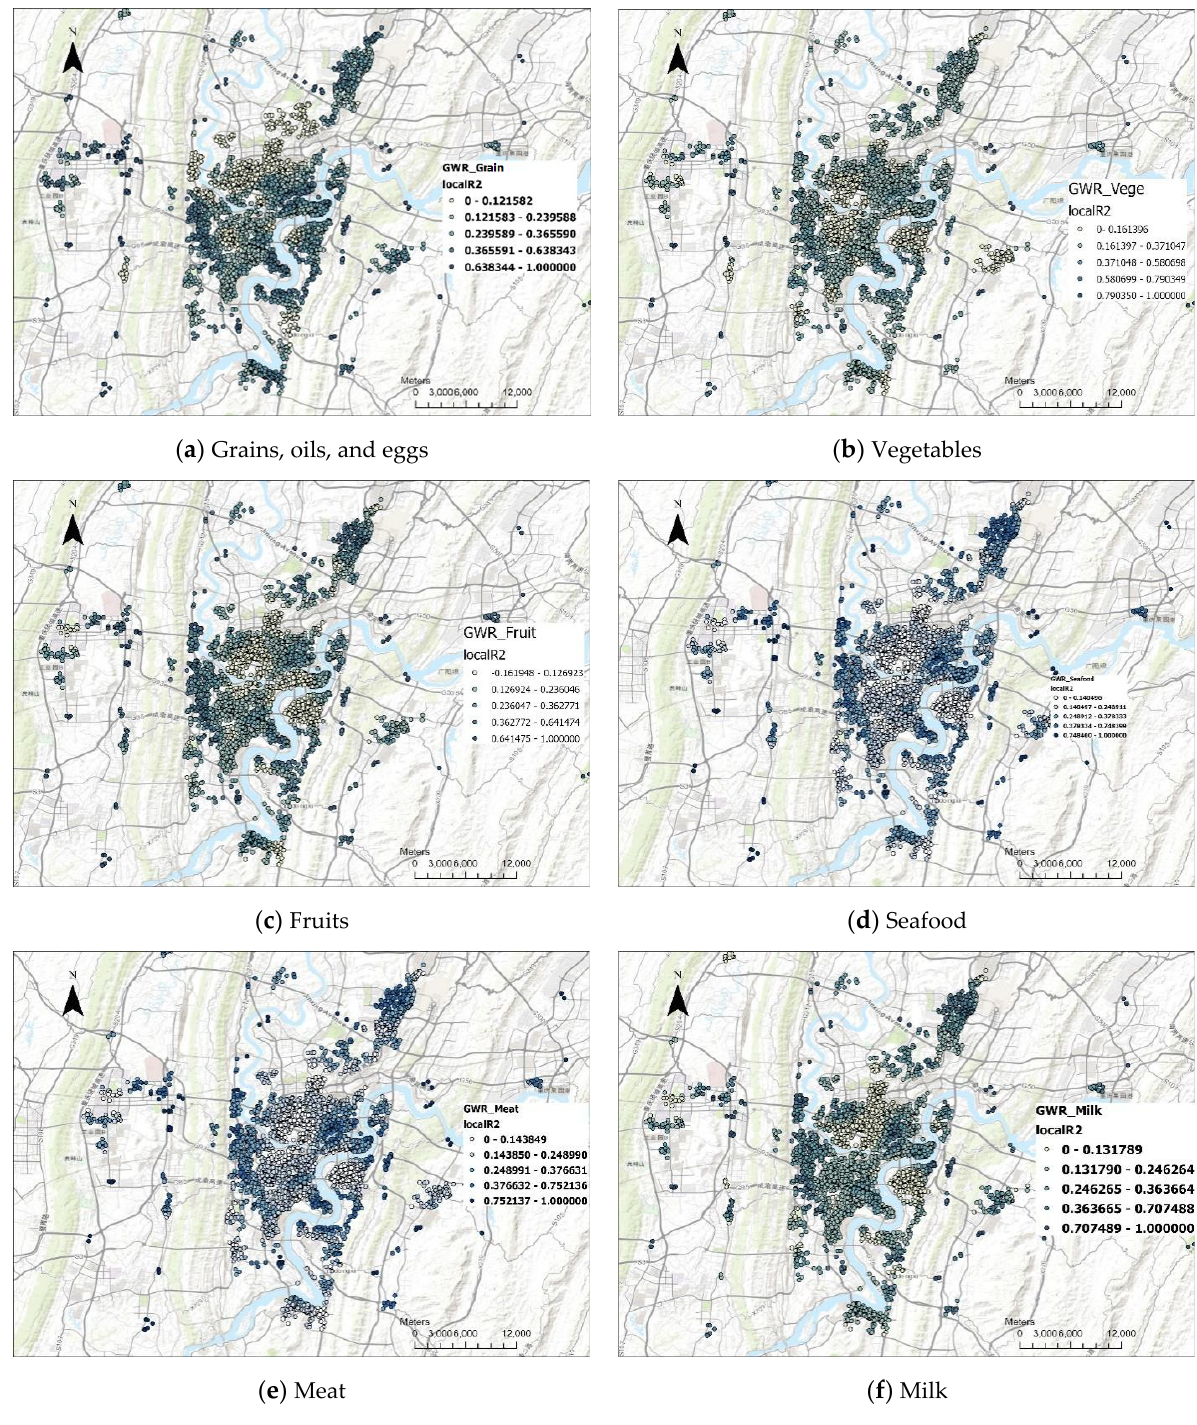
Figure 14. R 2 coeffects of grains, oils, and eggs; vegetables; fruits; seafood; meat; and milk in Chong- qing.